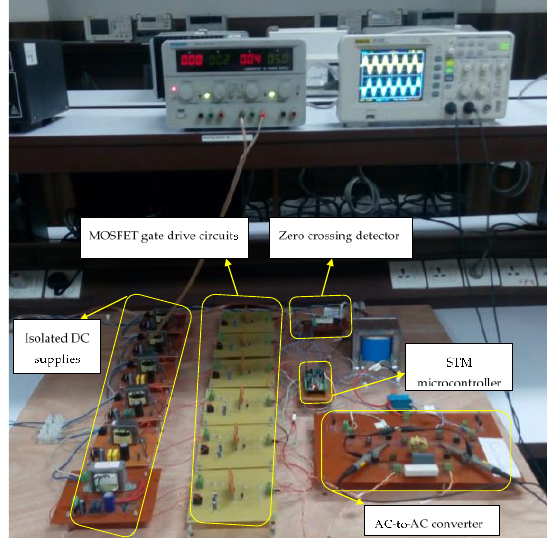
Figure 9. Hardware Setup.